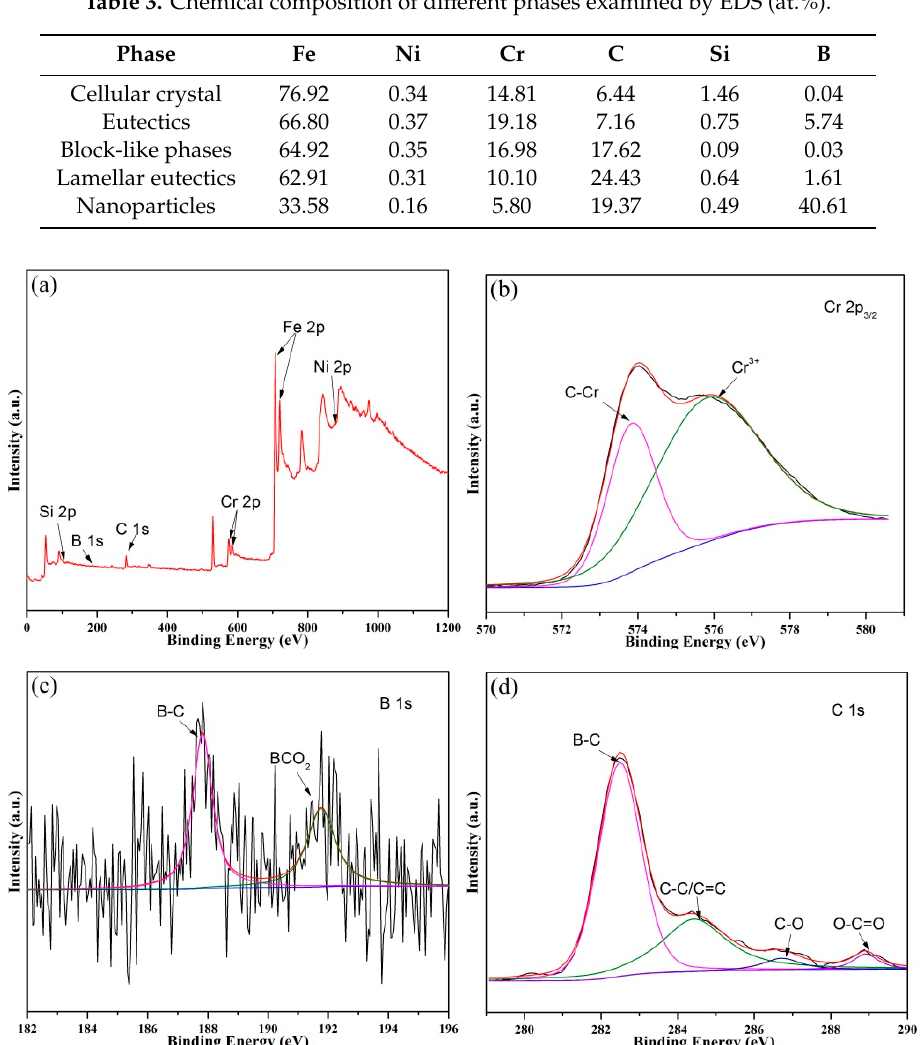
Figure 10. X-ray photoelectron spectra of Coating 2 ( a ), Cr 2 p ( b ), B 1 s ( c ), and C 1 s ( d ).